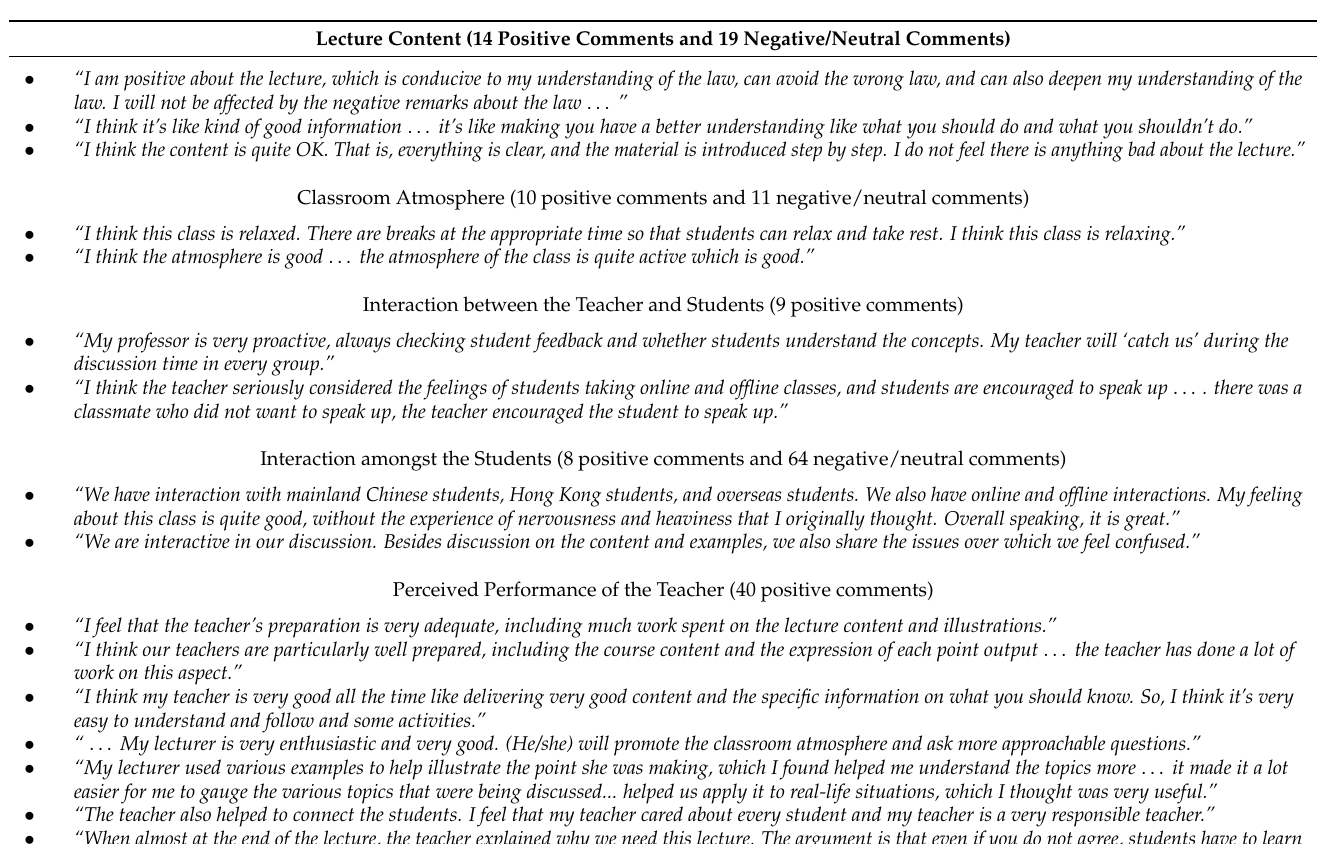
Table 2. Examples of positive narratives of the